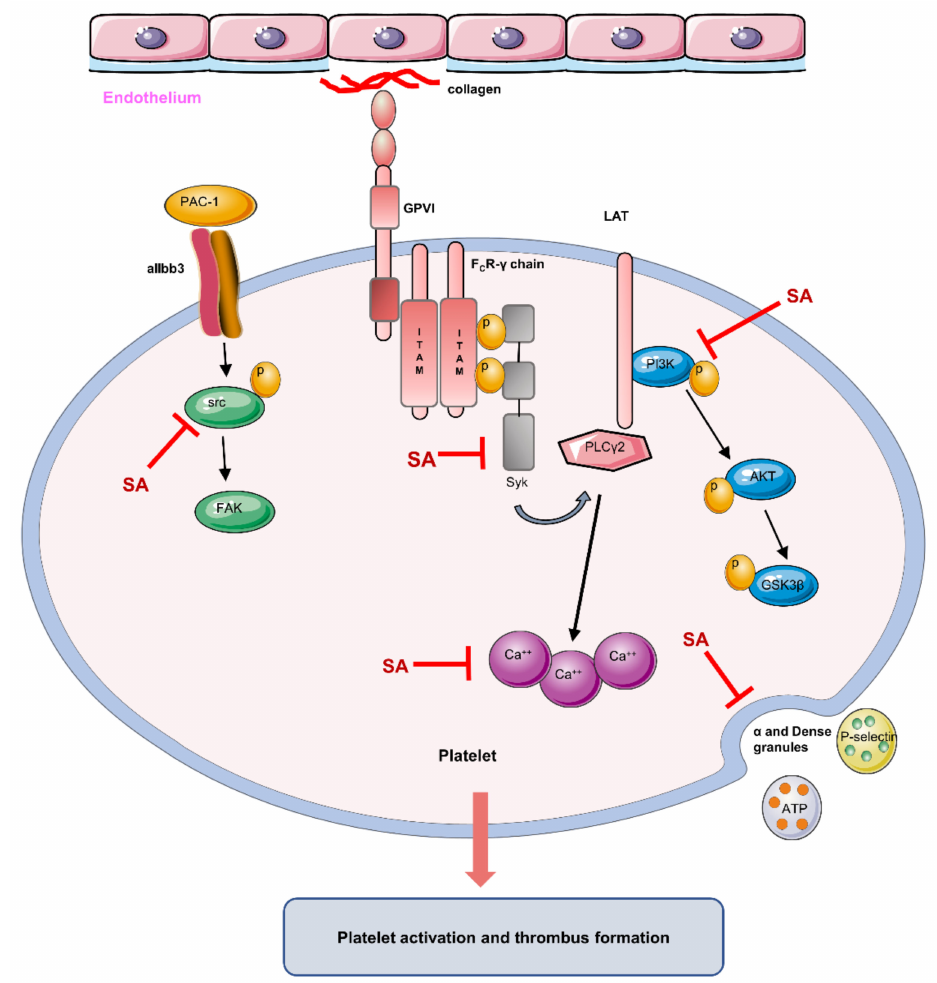
Figure 8. Schematic of sanguinarine antiplatelet activity. Sanguinarine attenuates collagen-induced platelet activation (including α and dense granule release) and thrombus formation by targeting the GPVI pathway (inhibiting the phospho- rylation of Syk-PLC γ 2 and PI3K-Akt-GSK3 β ), intracellular Ca 2+ mobilization and integrin α IIb β 3-mediated “outside-in” signal transduction (inhibiting the phosphorylation of src). (Inhibit ; Induce